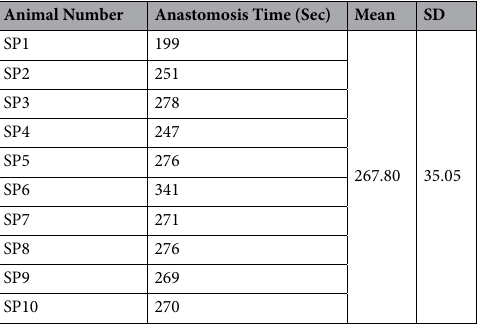
Table 1. Anastomotic time using a titanium vascular anastomotic device